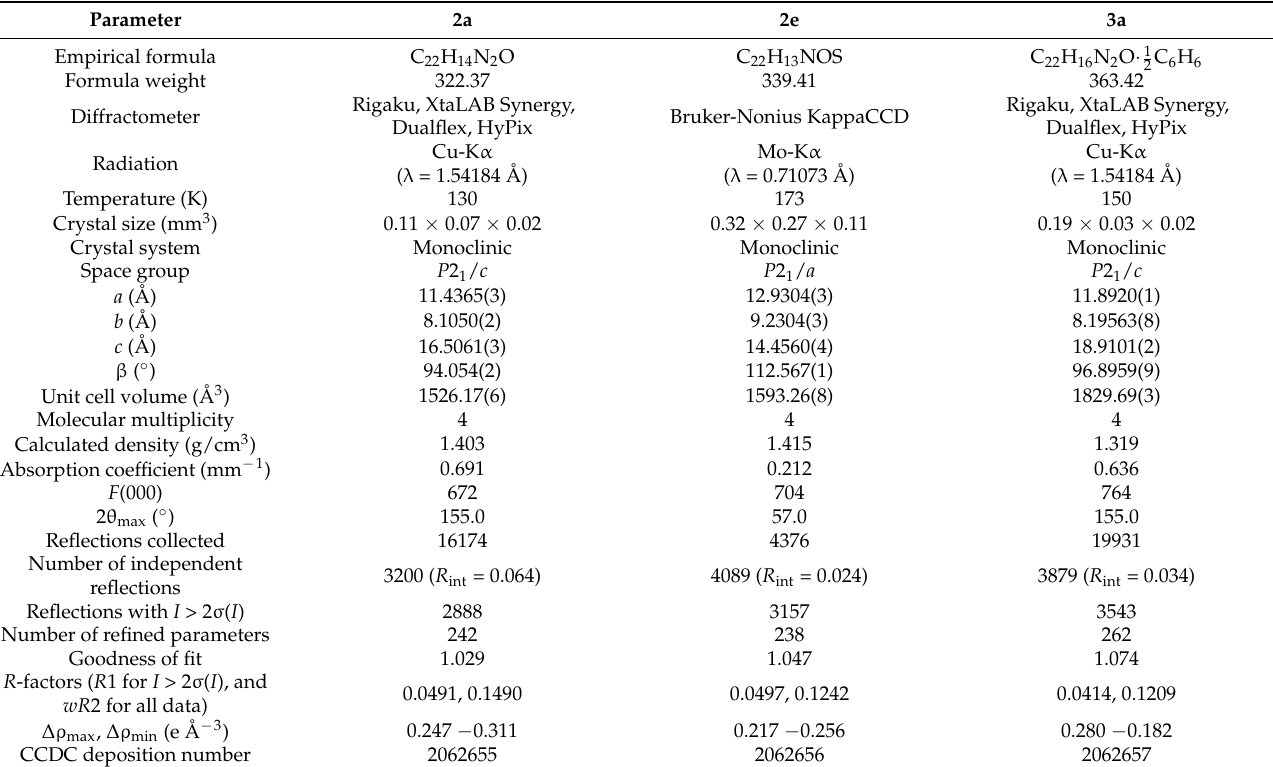
Table 5. Crystal data and structure refinement parameters for compounds 2a , 2e , and 3a